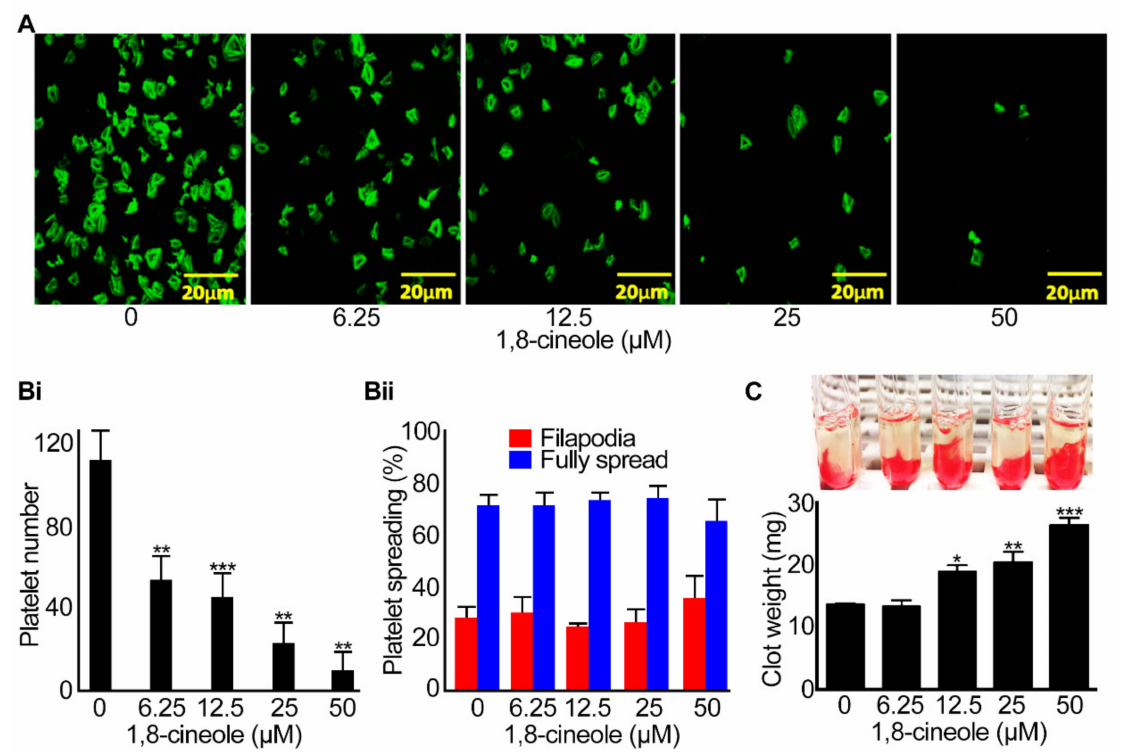
Figure 7. Effect of 1,8-cineole on integrin α IIb β 3-mediated outside-in signalling in human platelets. Human isolated platelets (at a density of 2x10 7 cells/mL) were incubated with a vehicle control (0) or different concentrations of